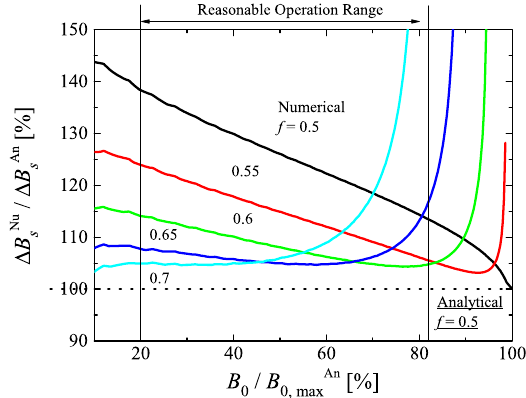
FIG. 9. Comparison of experiment and calculation: B bution along the z ¼ 0 . 4 ). u